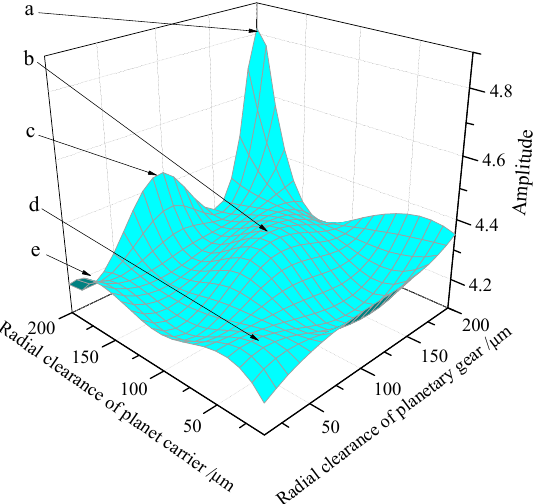
Figure 12. Radial vibration amplitude of planetary gears under different radial clearance.